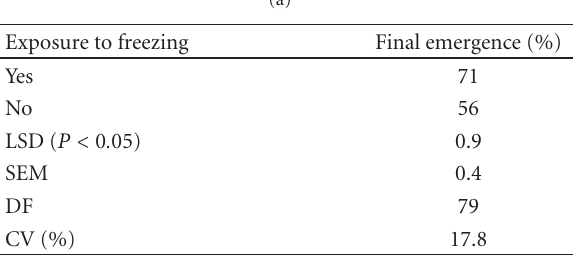
Table 2: E ff ect of exposure to freezing temperatures (a), timing and duration of freezing (b) and the timing of freezing ∗ duration of freezing and freezing temperature ∗ timing of freezing interactions (c) on final emergence (%) of seedlings from a winter wheat cv. Equinox seed lot naturally infected (88%) with Microdochium spp.